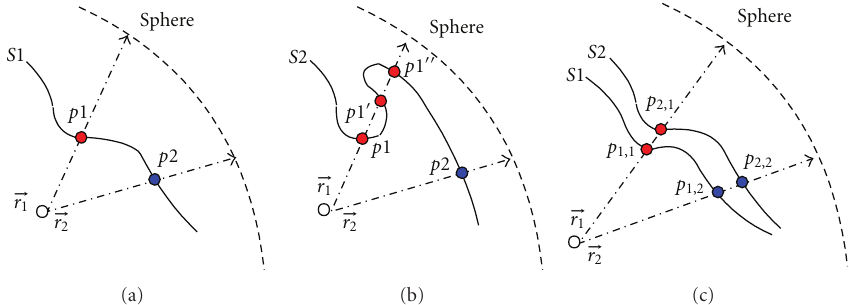
Figure 4: Ray casting sampling: (a) unique ray-surface intersection, (b) multiple ray-surface intersections, and (c) ray casting on two de- formed surfaces.